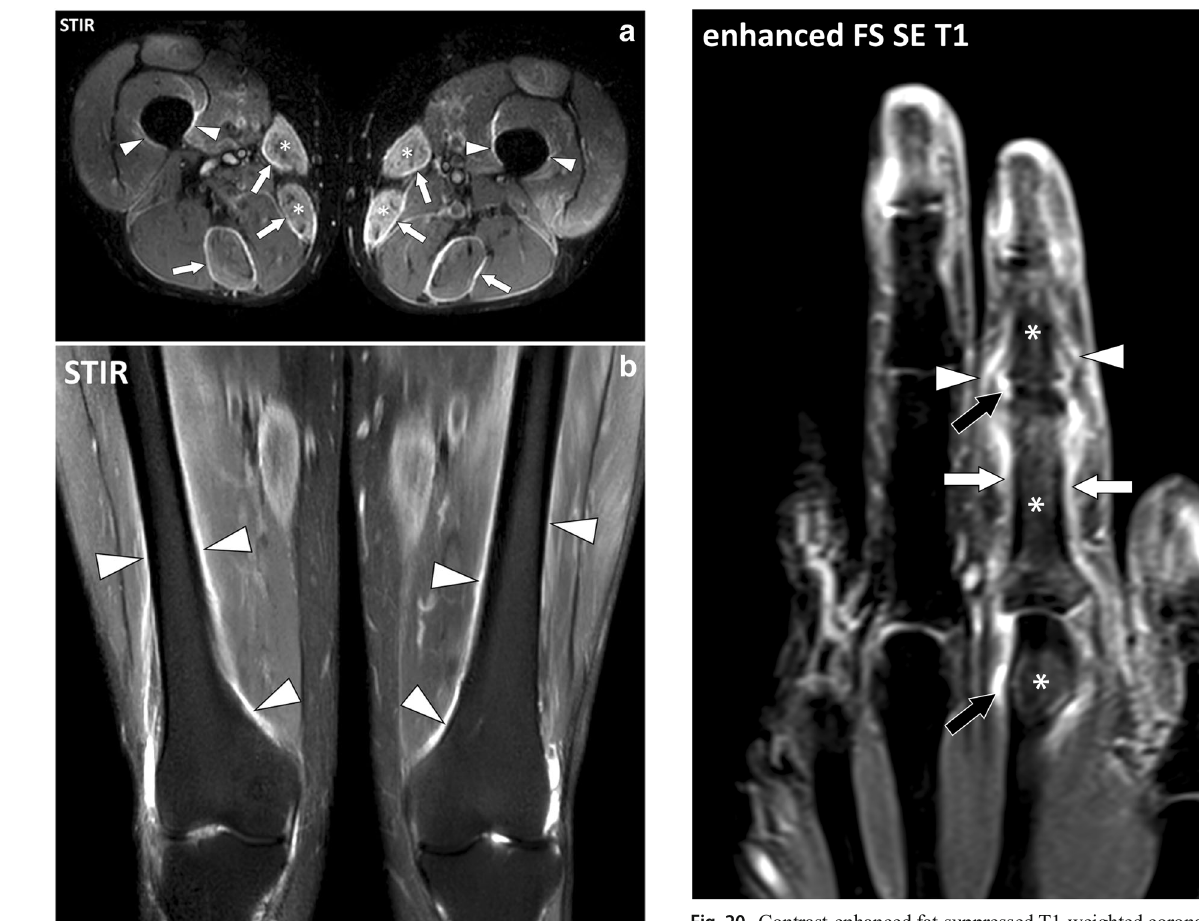
Fig. 19 Coronal STIR image of the thighs of a 43-year-old male with dermatomyositis (same as in Fig. 9). Involvement of the fascia superficialis of the medial part of the left thigh (asterisk) extends to the adjacent deep peripheral fas- cia (white arrows). The deep pe- ripheral fascia of the right thigh (black arrow) and the subaponeurotic connective tissues of the left vastus lateralis muscle (arrowhead) are also involved